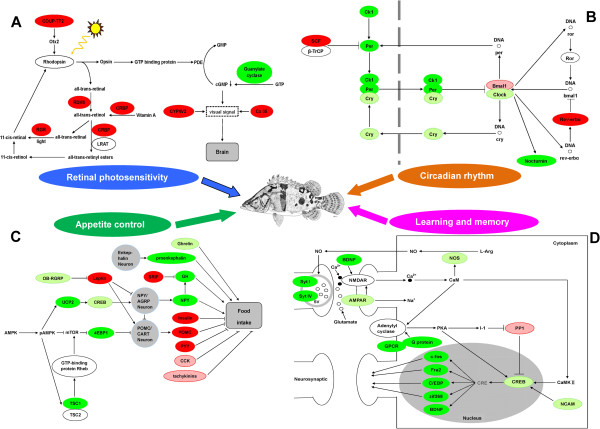
Differentially expressed genes between feeders and nonfeeders from transcriptome and DGE analysis. The most important pathways related to live prey food preference included retinal photosensitivity (A), circadian rhythm (B), appetite control (C), learning and memory (D). The colors of ellipses were shaded according to significance level (bright red: the mRNA expression levels of feeders were significantly higher than those in nonfeeders (FDR ≤ 0.001, the absolute value of log2[Ratio] ≥ 1); pink: the mRNA expression levels of feeders were slightly higher than those in nonfeeders (FDR ≤ 0.5, the absolute value of log2[Ratio] ≥ 0.5); bright green: the mRNA expression levels of feeders were significantly lower than those in nonfeeders (FDR ≤ 0.001, the absolute value of log2[Ratio] ≥ 1); pale green: the mRNA expression levels of feeders were slightly lower than those in nonfeeders (FDR ≤ 0.5, the absolute value of log2[Ratio] ≥ 0.5).